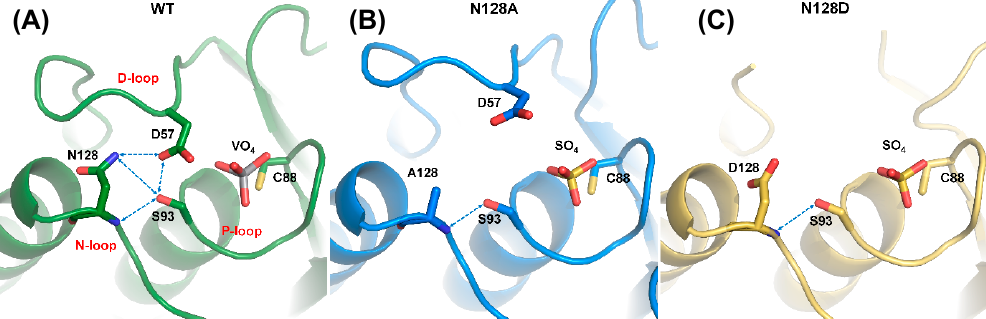
Figure 5. Disruption of DPN–triloop interaction in the crystal structures of N128 mutants. ( A – C ) The crystal structures of WT (green), N128A (blue), and N128D (yellow) indicated how the mutation affected the hydrogen bonding network and D-loop. The hydrogen bonds are shown by blue dotted lines. ( A ) The crystal structure of WT was co-crystallized with vanadate, and the DPN–triloop interaction was maintained. ( B ) N128 was replaced with alanine, and the conformation of the D-loop changed. Only one hydrogen bond was formed between the side chain of S93 and backbone amide of N128. ( C ) N128 was replaced with a somatic mutant, aspartate. The D128 induced charge repulsion with D57 and resulted in a dynamic D-loop that had unclear electron density.